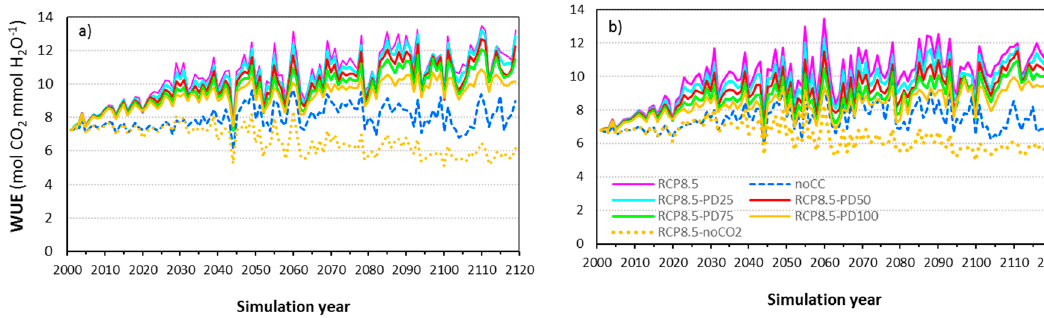
Figure 7. Effects of the climate change scenario RCP8.5 with constant CO 2 concentration (370 ppm—global mean of 2018) (RCP8.5-CO 2 ) and with increasing CO 2 concentration assuming photosynthetic downregulation by 25, 50, 75 and 100% (RCP8.5_PD25, RCP8.5_PD50, RCP8.5_PD75, RCP8.5_PD100) on water use efficiency (WUE) of beech ( a ) and fir ( b ). The climate scenario noCC is displayed for comparison assuming no change in precipitation and temperature and constant CO 2 concentration.